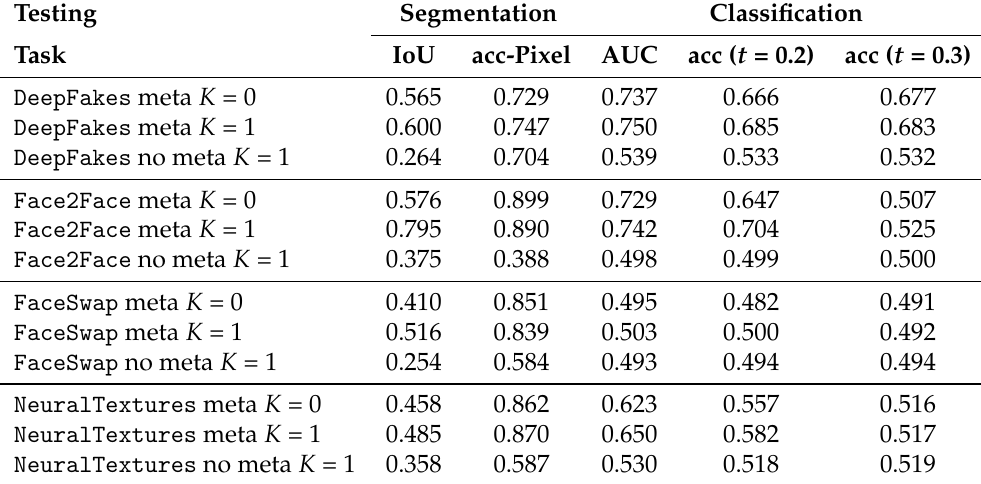
Table 1. Results for meta-learning of detecting C23 crop images altered by the unseen manipulation methods with initial weights deduced by the proposed method (inner loop iteration 1) and with K -shot fine-tune. In this table, acc-pixel stands for pixel-wise accuracy. In this table, we use the symbol t to denote the threshold. For instance, when t = 0.3, it indicates that the threshold value is 30%. The IoUs and acc-pixels in this table are the average results for each image in the test